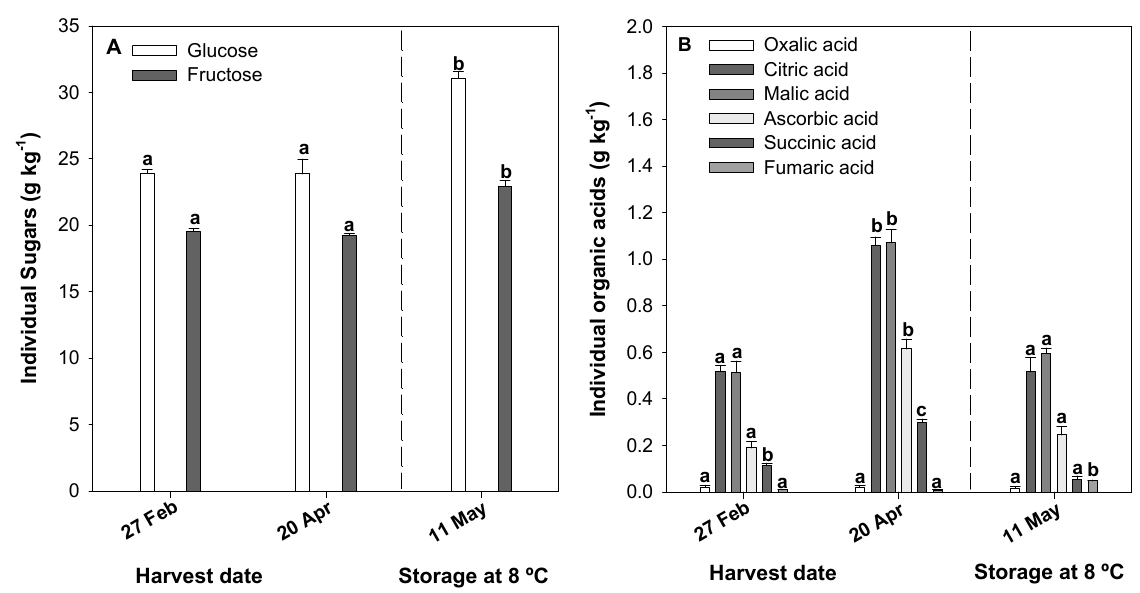
Figure 5. Influence of harvest date (27 February and 20 April) and postharvest storage (at harvest; 20 April, and at 21 storage days; 11 May) on individual sugar ( A ) and organic acid ( B ) levels (g kg − 1 ) in green pepper fruit. Lowercase letters show significant differences ( p < 0.05) among harvest dates and storage days at 8 °C.